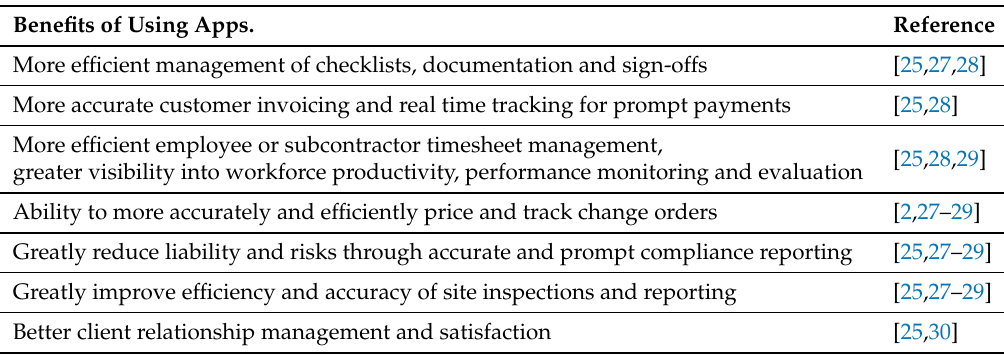
Table 1. Benefits of Using Apps